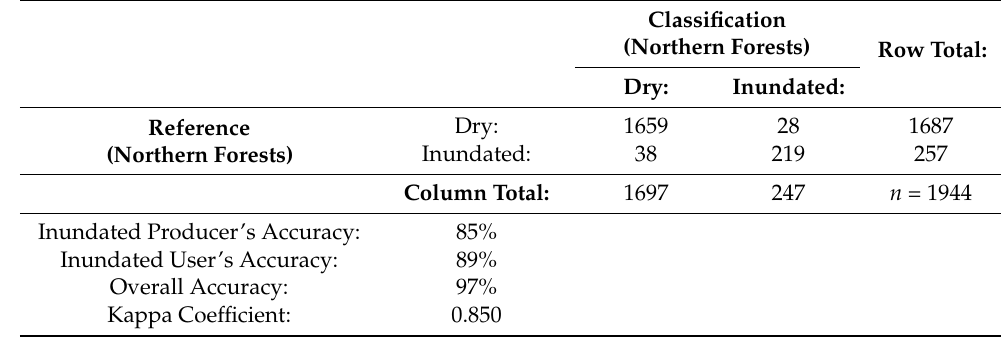
Table 4. The confusion matrix for the LandTrendr model in the Northern Forests Ecoregion. The performance of the LandTrendr model when compared to manual interpretation of independent satellite imagery in the Northern Forests ecoregion (northern and northeastern parts of the state). Overall accuracy is high at 97%, producer’s and user’s accuracies for the inundated class are 85% and 89%, respectively. This suggests good performance of the LandTrendr model, similar to the overall accuracy, in identifying surface water in this region.